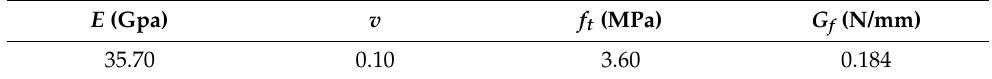
Table 6. Concrete material